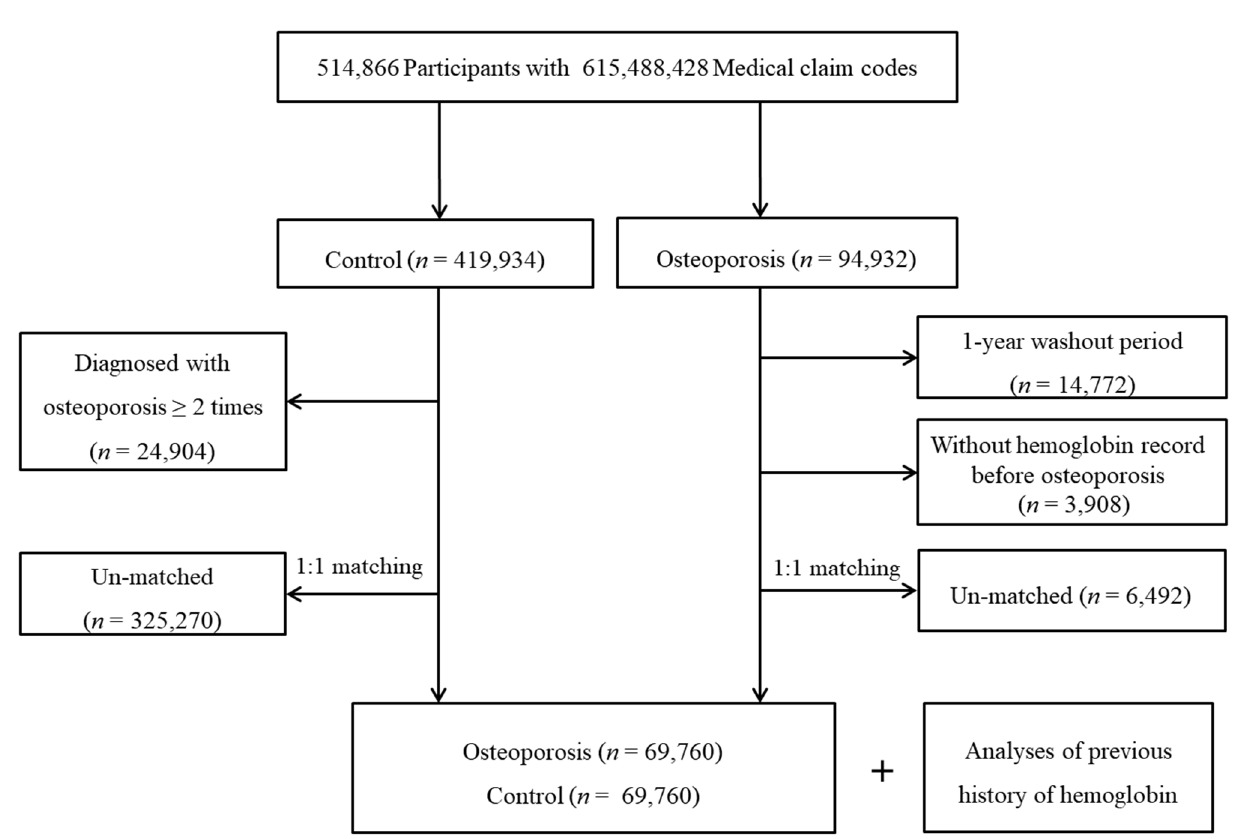
Figure 1. A schematic illustration of the participant selection process that was used in the present study. Of a total of 514,866 participants, 69,760 osteoporosis patients were 1:1 matched with 69,760 comparison participants for age, sex, income, and region of residence.